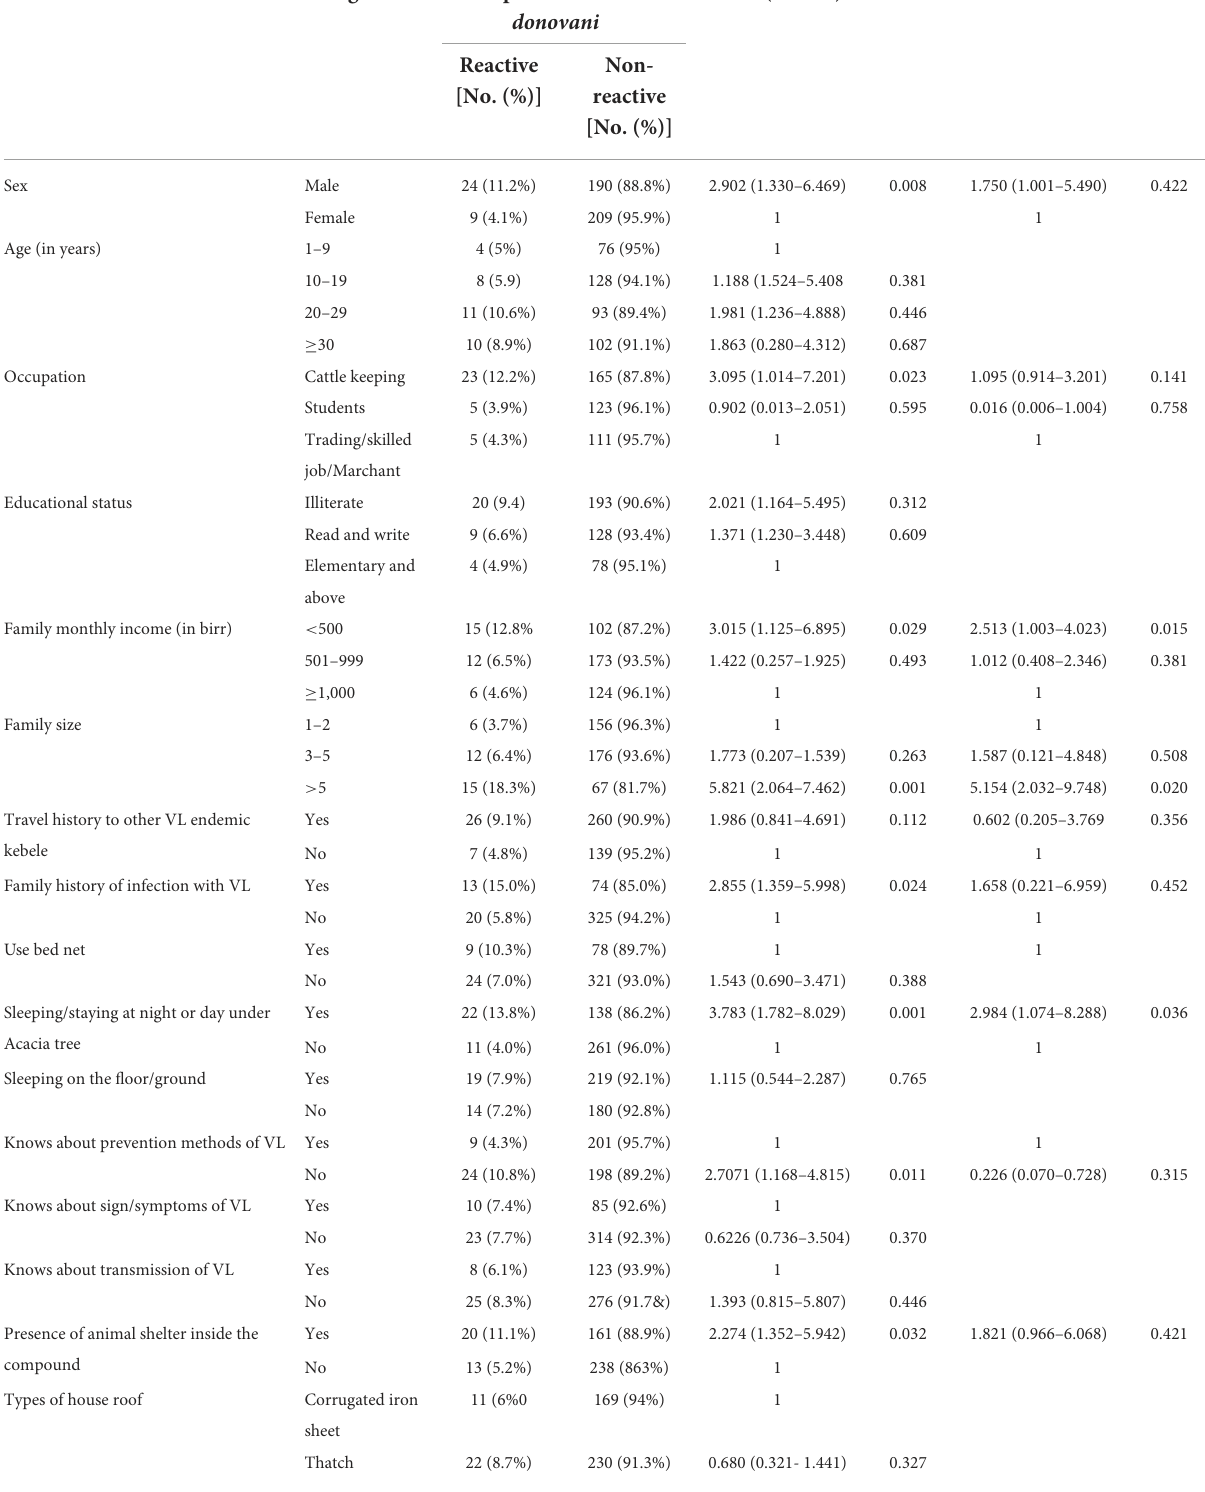
TABLE 4 Bivariable and multivariable logistic regression analysis factors associated with seroprevalence of visceral leishmaniasis in Dire District, Borena zone, Oromia Region, Ethiopia, 2021.